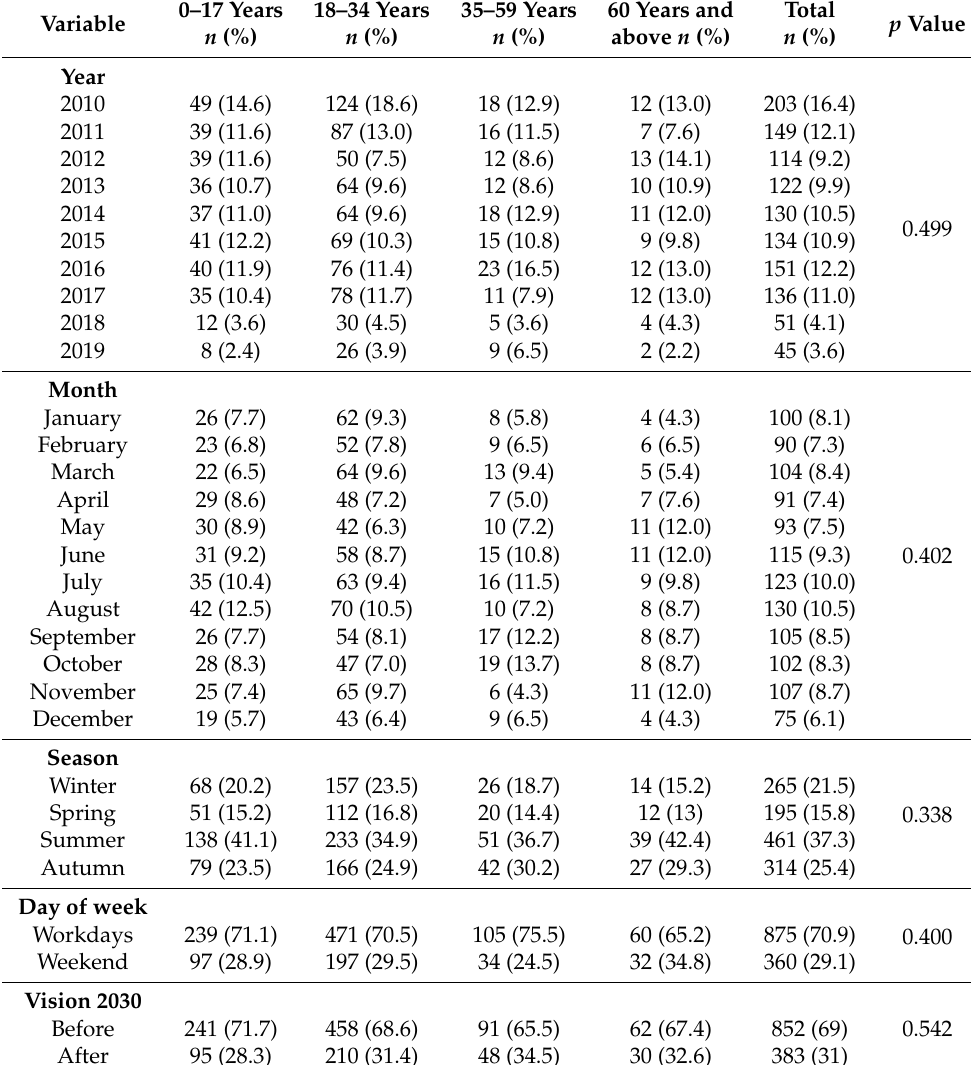
Table 3. Time trends and seasonal variation in head injury cases by age ( n =